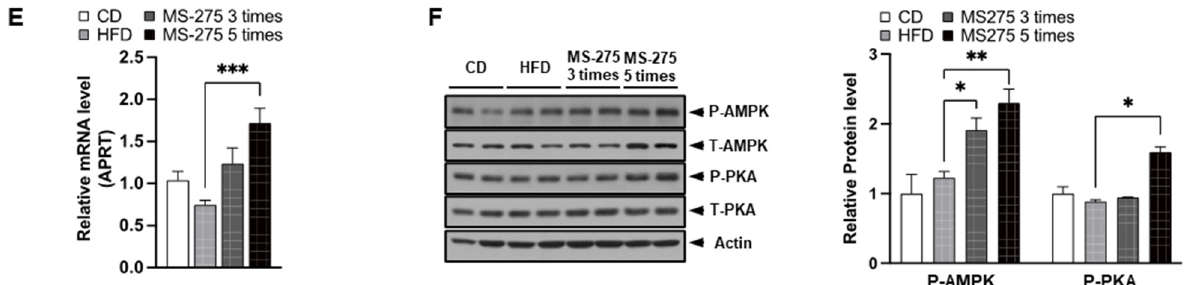
Figure 4. MS-275 induced lipophagy and increased lipolysis-related gene expression in HFD-induced fatty liver. ( A ) Co-localization of LDs and lysosomes in liver tissue from MS-275-treated mice was visualized by two-photon microscopy staining with LD1 (red) for LDs and BLT (green) for lysosomes. Scaled-up and z-stack image represents LDs surrounded by lysosomes; ( B ) Cellular organelles in liver tissues of MS-275-treated mice were visualized by transmission electron microscopy (TEM). Red arrows indicates lipophagy; ( C ) Conversion of LC3I into LC3II and p62 degradation in liver tissues of MS-275-treated mice was detected by immunoblotting; ( D ) Expression levels of genes related to lipolysis (Lipc, Pnpla2, Lipe, and Mgll) were determined by quantitative reverse transcriptase-polymerase chain reaction (qRT-PCR); ( E ) Expression levels of Aprt were determined by qRT-PCR; ( F ) p-AMPK and p-AKT levels in liver tissues of MS-275-treated mice were determined by immunoblotting. * p < 0.05, ** p < 0.01 and *** p < 0.001 (one-way ANOVA).